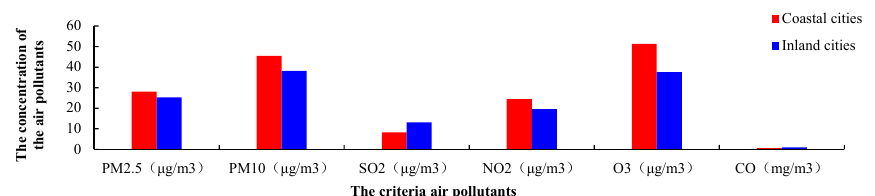
Figure 3. Two-year average concentrations of the six criteria pollutants in two topographic categories (coastal cities and inland cities).